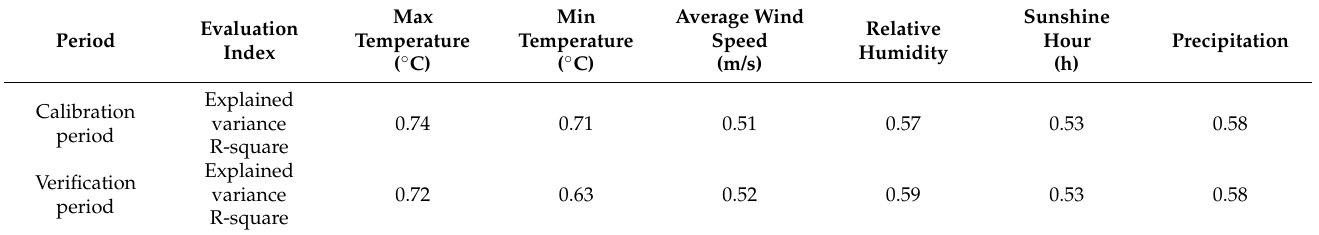
Table 3. Simulation results of scale reduction in the piedmont plain area in Hebei